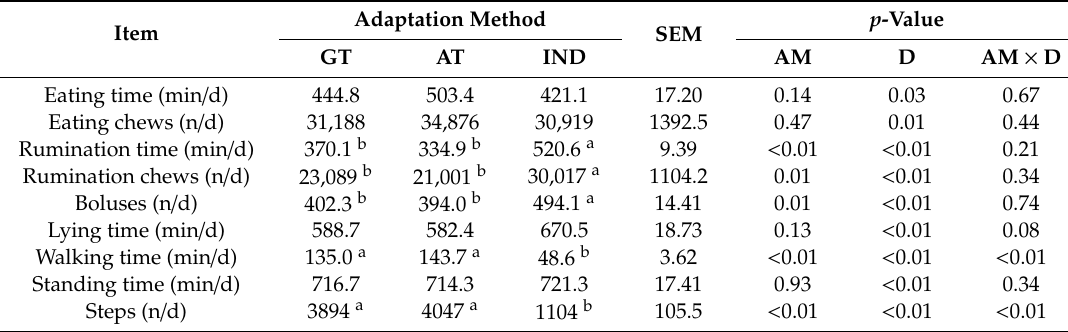
Table 3. Mean values of variables related to feeding and locomotion behavior ( n =